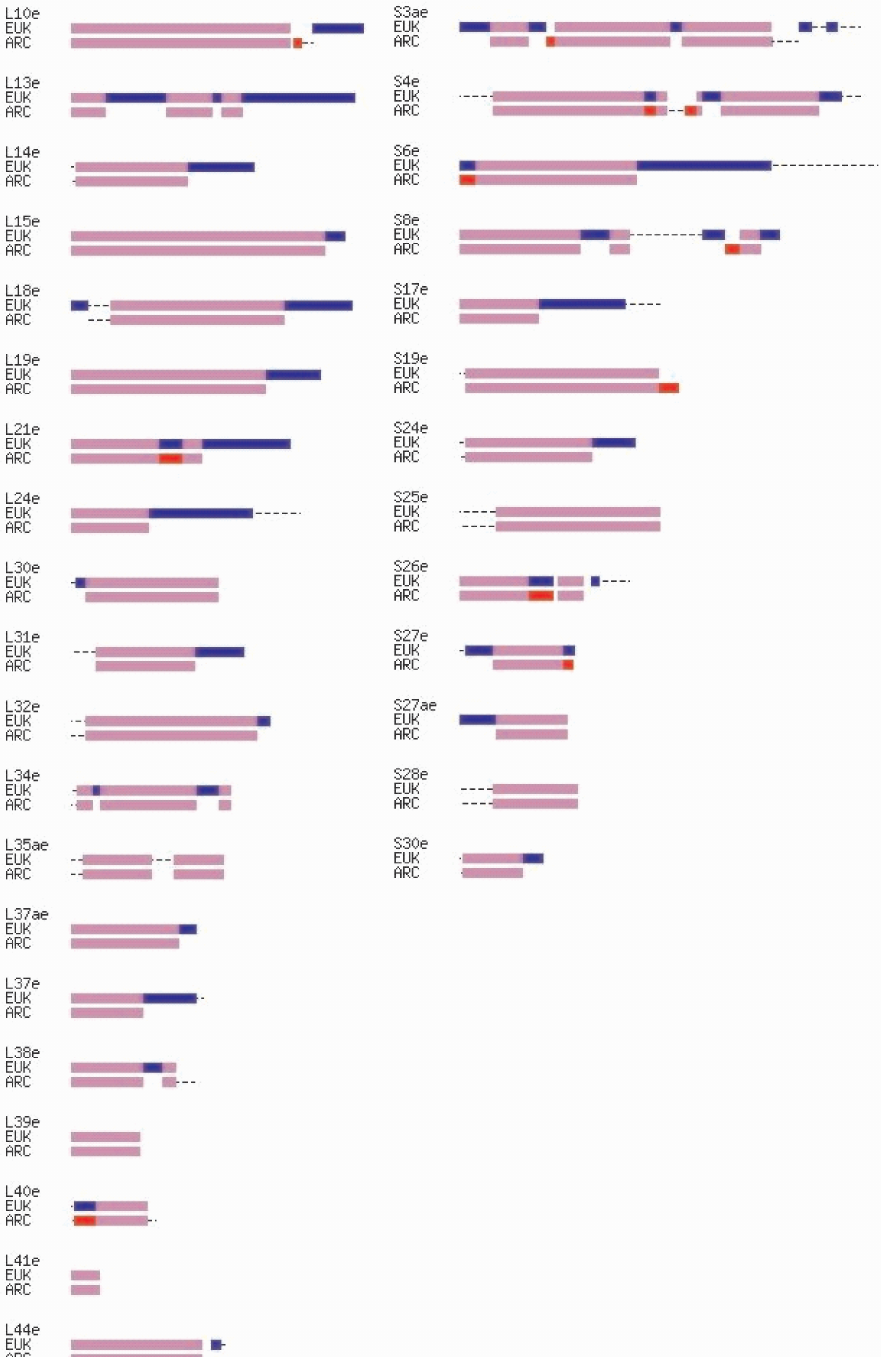
Figure 1. A schematic repre- sentation of the multiple align- ments of the 33 ribosomal proteins common to Archaea and Eukarya. Purple marks segments alignable, and thus homologous, across both phylogenetic domains; blue marks segments unique and alignable only within Eukarya; red marks segments alignable only within Archaea. Dotted lines represent sequence re- gions of varying length that are unalignable across the full sets of either Eukarya or Archaea. The representative species are listed in the legend of Figure